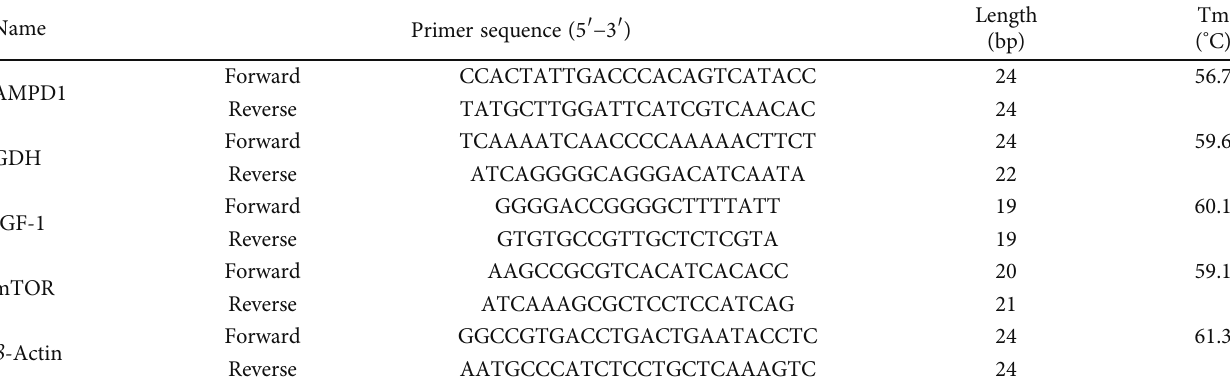
Table 3: Sequence of primers used for real-time quantitative